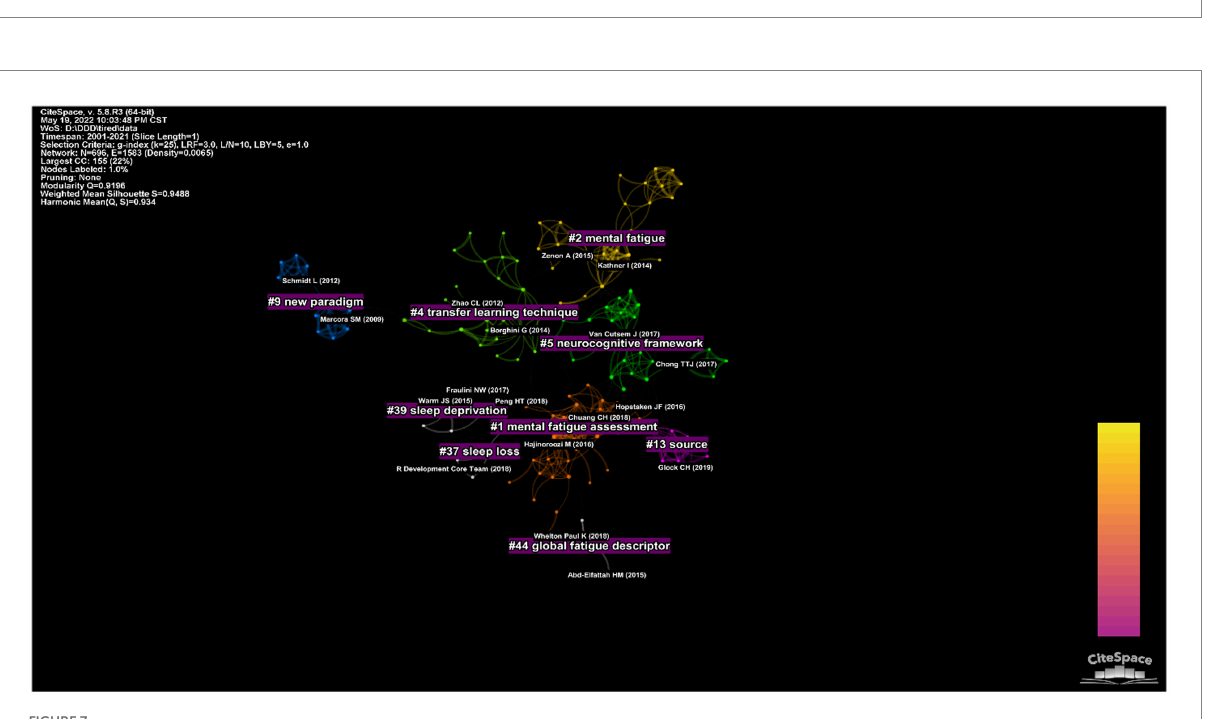
FIGURE 7 The co-citation cluster network visualization map of references based on